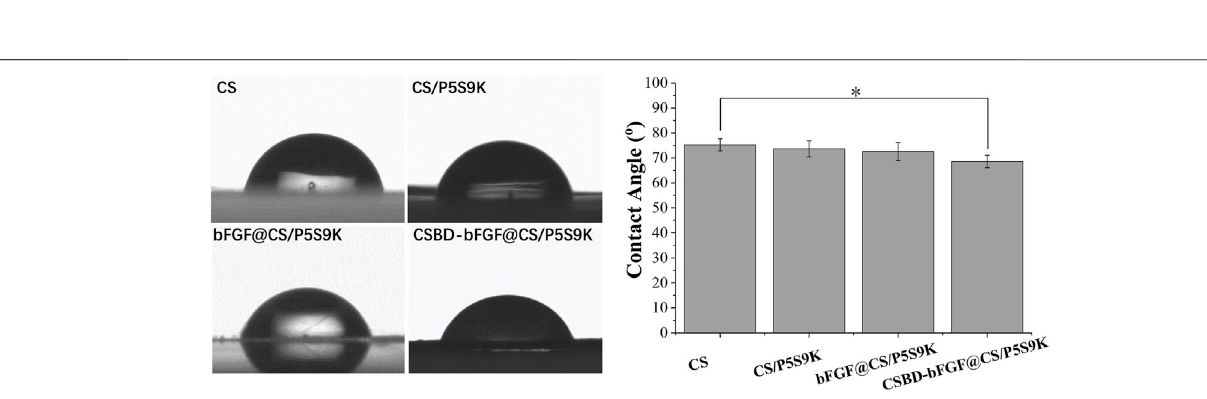
Frontiers in Bioengineering and Biotechnology |